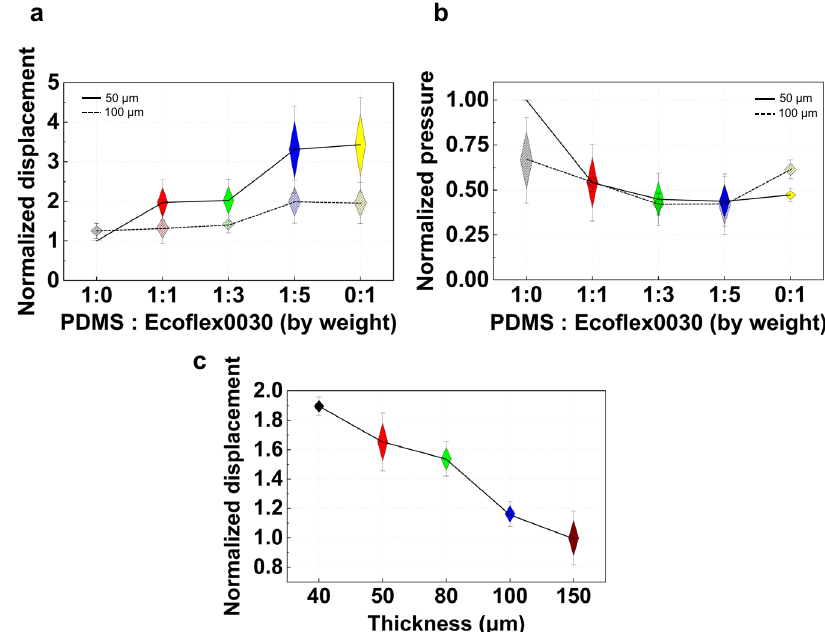
Fig. 3 Optimization of stretchable layer properties. a Measured displacement of the membrane with different PDMS: Eco fl ex0030 (by weight). b Measured force of the membrane with different PDMS: Eco fl ex0030 (by weight). c Measured displacement of the membrane with different thicknesses. Data are presented as mean ±